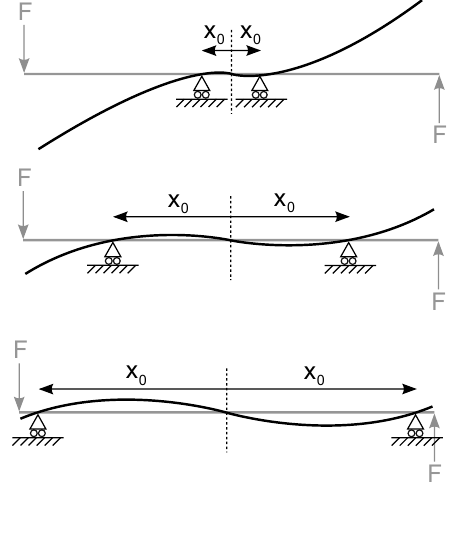
Figure 2. The working principle of the variable stiffness mechanism. The deflection shape of the leaf spring is varied by changing the location of the supports, and therefore, the perceived stiffness at the location of the force application points is